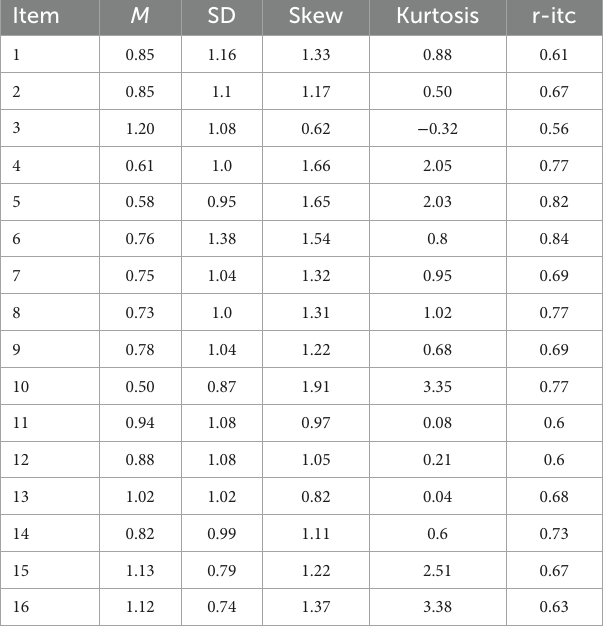
TABLE 2 Descriptive statistics and reliability of the Spanish version of the BFS-E questionnaire.